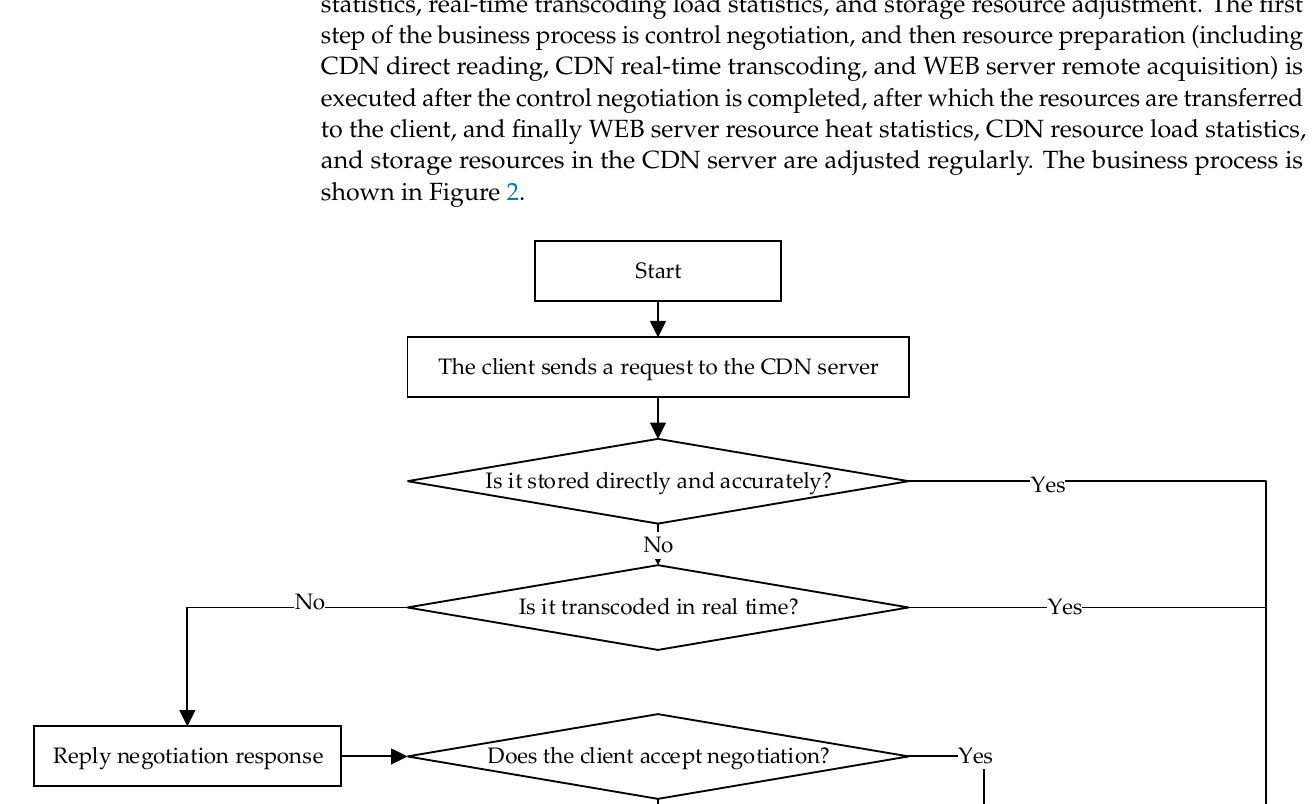
Figure 2. Flow-process diagram of the data service.